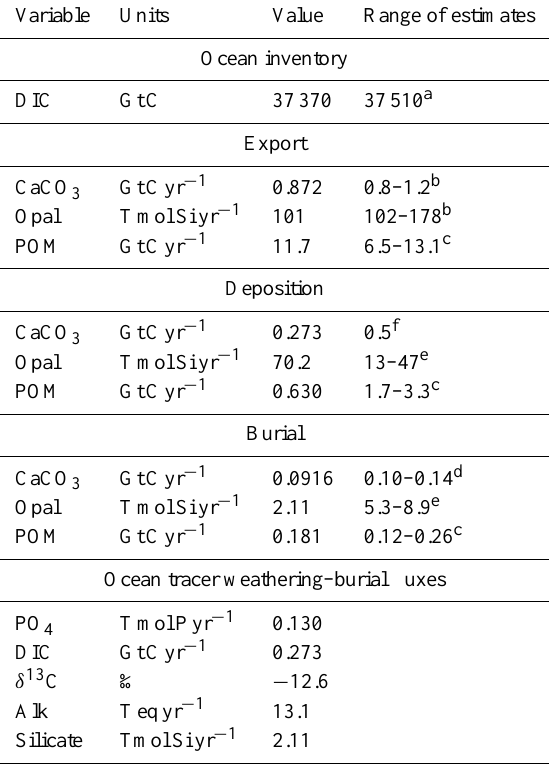
Table 1. Overview of globally integrated particle fluxes for a prein- dustrial control